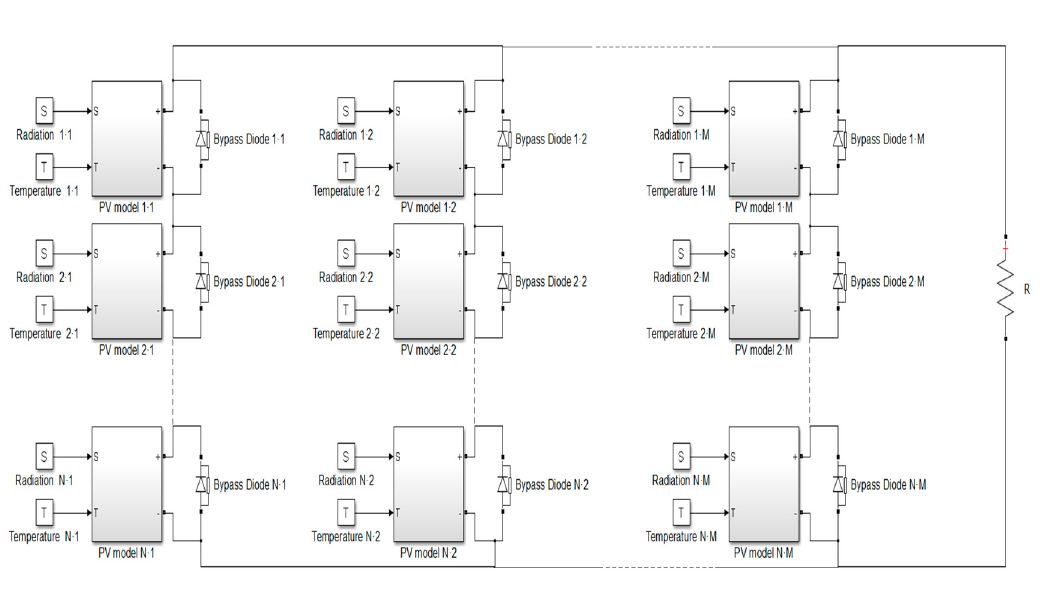
Figure 7. Simulated PV array model.